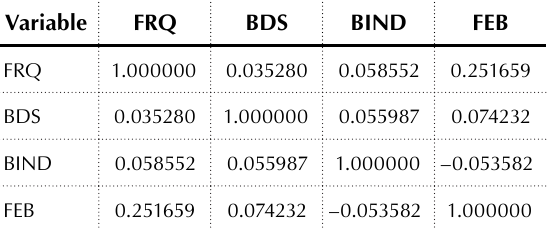
Table 2. Correlation